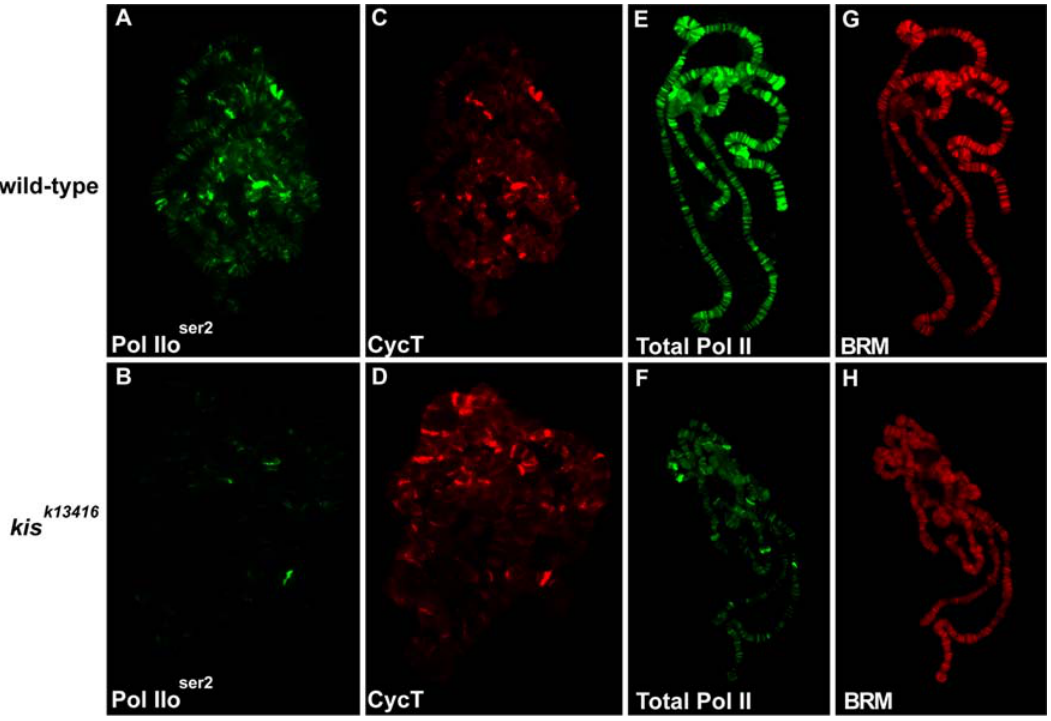
Figure 1. KIS-L facilitates an early stage in transcriptional elongation. Polytene chromosomes isolated from wild-type (A, C, E, and G) and kis k13416 (B, D, F, and H) larvae were stained with antibodies against Pol IIo ser2 (A, B) and the CycT subunit of P-TEFb (C, D) or the CTD of RPB1 (that recognizes hypo- and hyper-phosphorylated forms of Pol II) (E, F) and BRM (G, H). The levels of total Pol II and Pol IIo ser2 are reduced in kis mutants while the levels of BRM and CycT are not